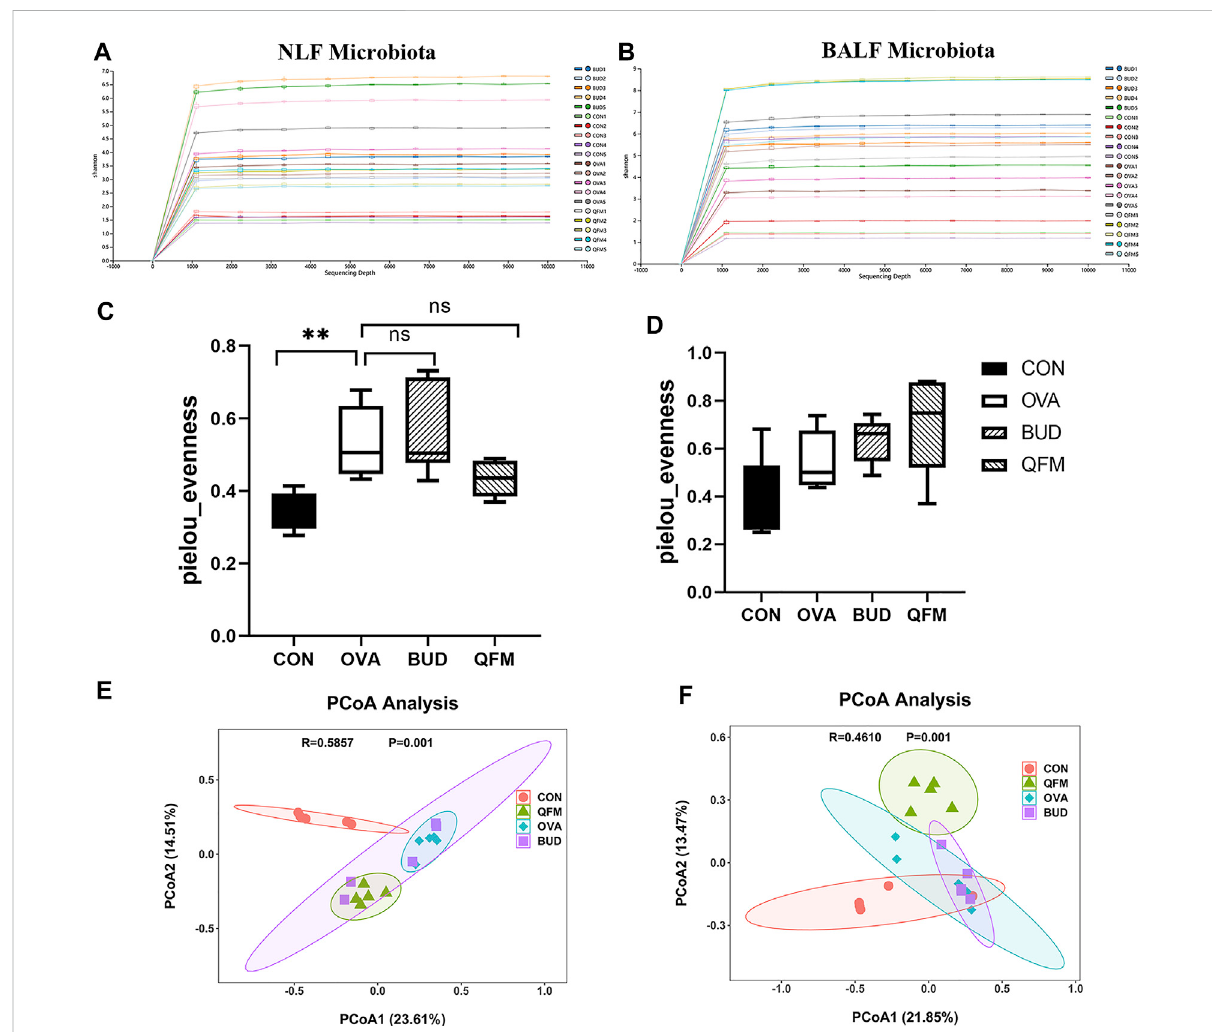
FIGURE 4 Effects of Qingfei oral liquid (QF) on the diversity of the respiratory microbiota in ovalbumin (OVA)-induced asthmatic mice. (A) The alpha rarefaction curve in nasal lavage fl uid (NLF) microbiota. (B) The alpha rarefaction curve in bronchoalveolar lavage fl uid (BALF) microbiota. (C) α diversity analysis (using the Pielou ’ s evenness) of the NLF microbiota. (D) α diversity analysis (using the Pielou ’ s evenness) of the BALF microbiota. (E) PCoAplotshowingthe β diversityofNLFmicrobiota( p =0.001). (F) PCoAplotshowingthe β diversityofBALFmicrobiota( p =0.001).PCoAofall samples using weighted UniFrac distance. PCoA, principal coordinates analysis. ( n = 5 in each